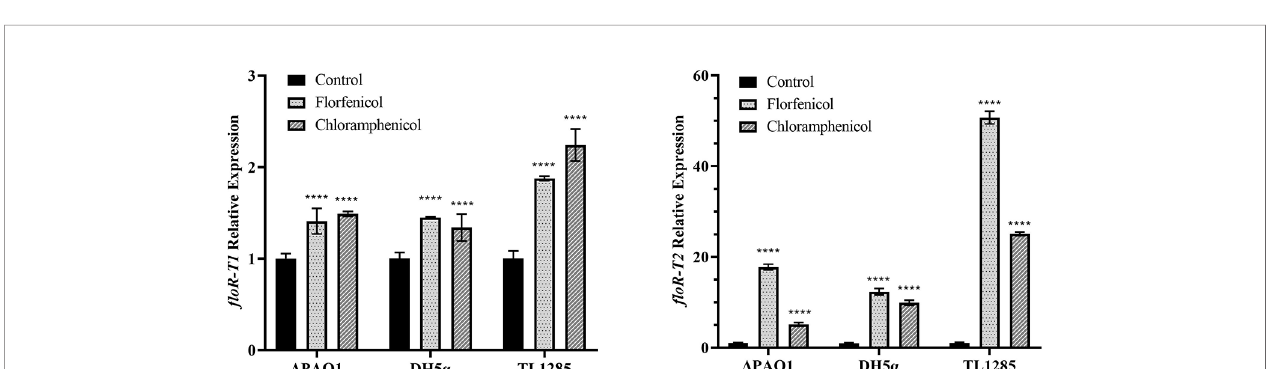
FIGURE 2 | Expression of the fl oR variants in TL1285 and corresponding transformants with or without fl orfenicol or chloramphenicol induction. **** (P-value < 0.0001).